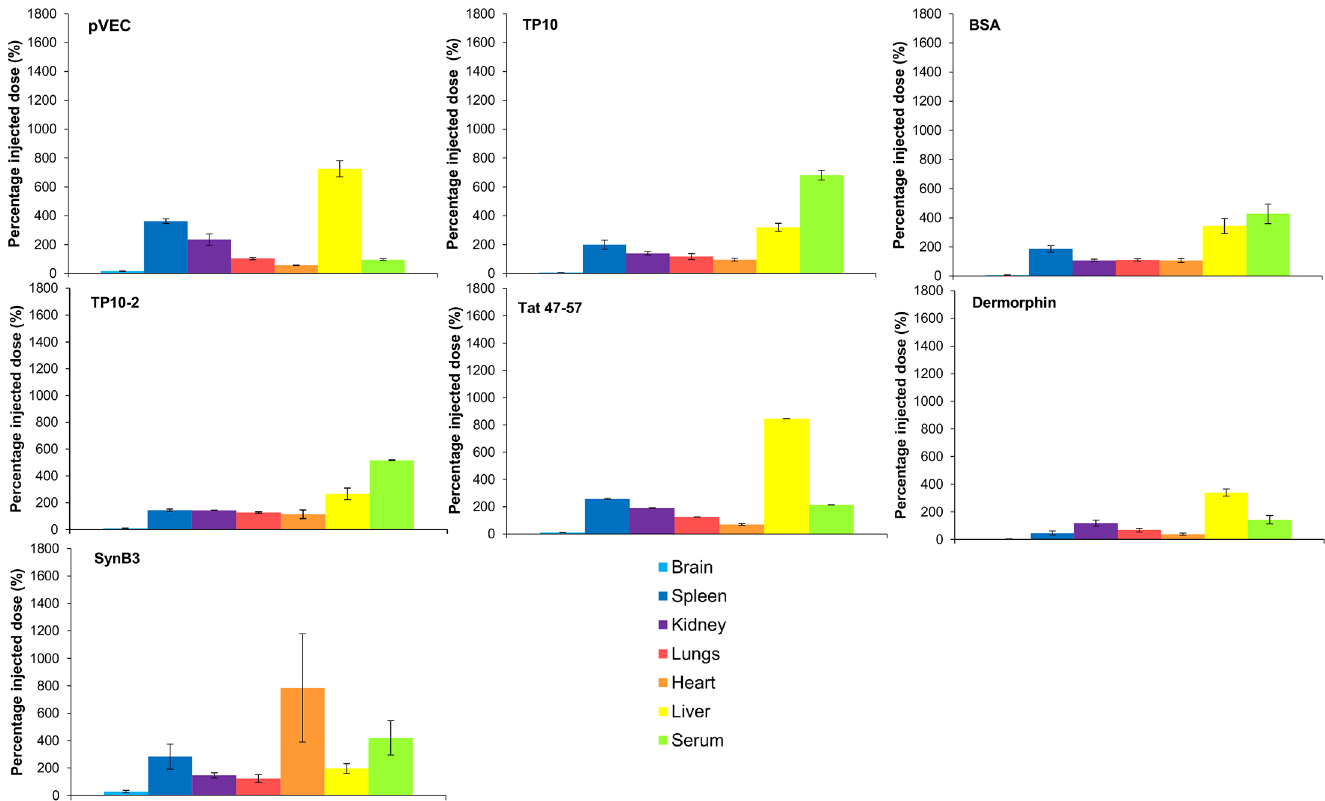
Fig 5. Relative tissue distribution of the radiolabeled CPPs and the controls dermorphin and radioiodinated BSA 15 min post IV injection expressed as the percentage of the injected dose ( ± SEM, n = 2). From the left to the right: brain (light blue), spleen (dark blue), kidneys (purple), lungs (red), heart (orange), liver (yellow) and serum (light